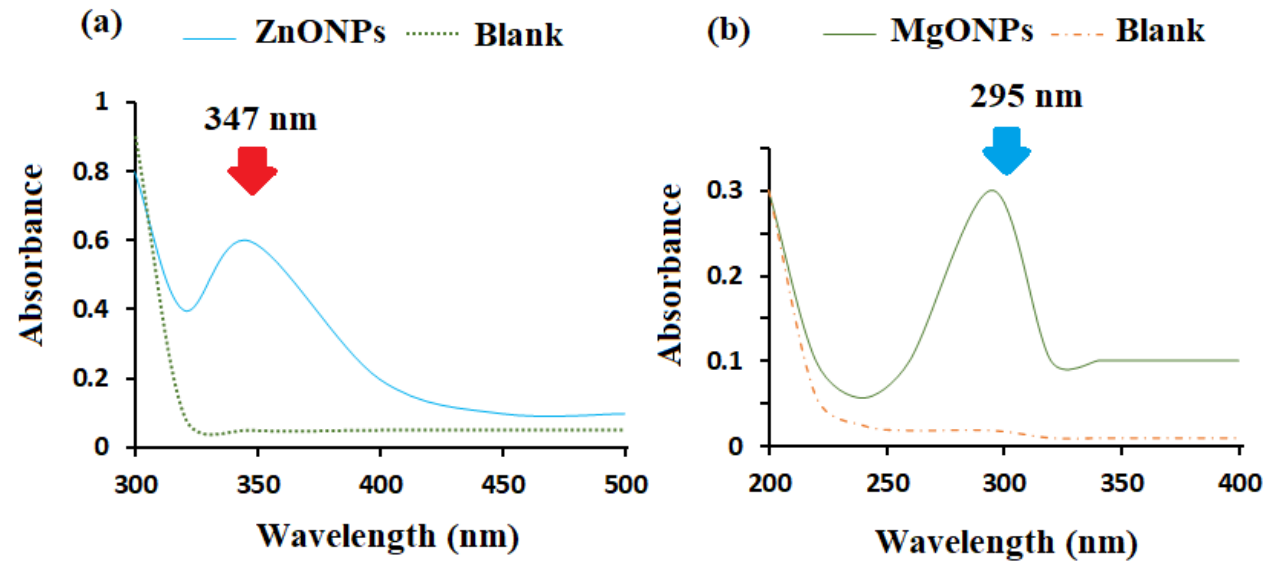
Figure 3. The UV–Vis spectra of ( a ) ZnONPs and ( b ) MgONPs at 347 and 295 nm, respectively.